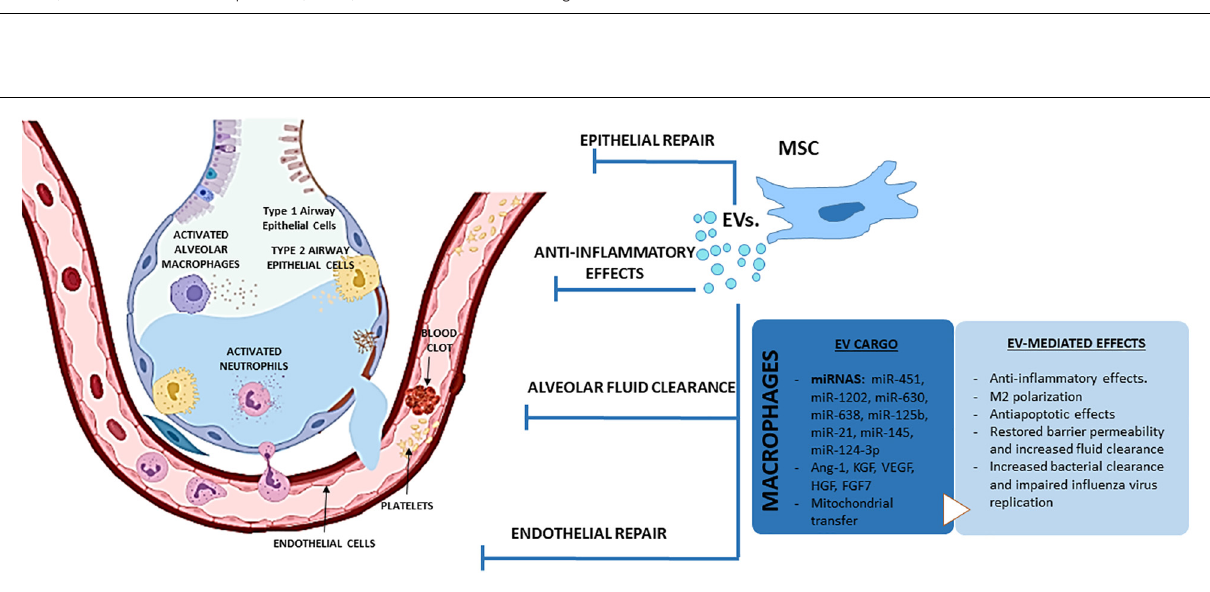
FIGURE 2 | Therapeutic potential of extracellular vesicles (EVs) derived from mesenchymal stem cells (MSCs) in acute respiratory distress syndrome (ARDS). Schematic diagram showing the protecting effects of the protective effects induced by EVs derived from MSCs in ARDS. Potential mediators and described protective effects are shown in the right panels. Ang-1, angiopoetin-1; FGF7, fibroblast growth factor 7; HGF, hepatocyte growth factor; KGF, keratinocyte growth factor; M2, M2 or anti-inflammatory macrophages; miR, micro ribonucleic acid; MSC, mesenchymal stem cell; VEGF, vascular endothelial growth factor. This figure was created with